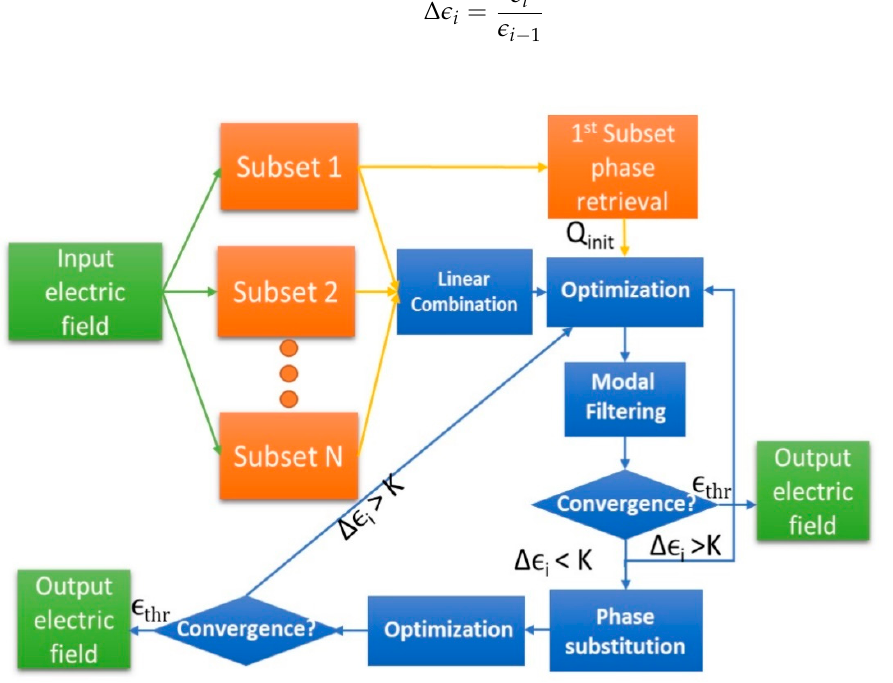
Figure 4. Iterative optimization algorithm.